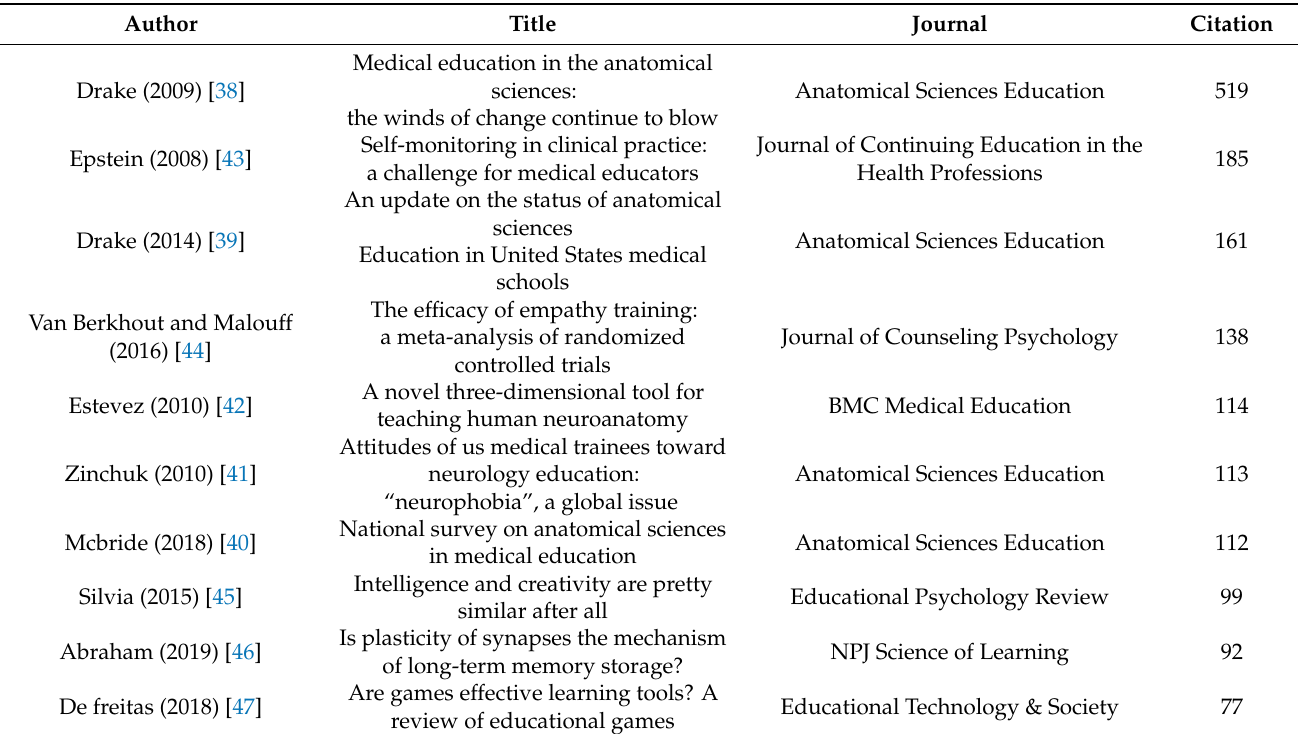
Table 6. Top 10 most influential